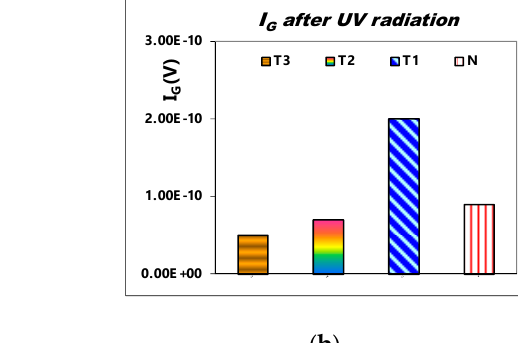
Figure 8. ( a ) The gate-current comparison at V G 30V for various SAHAOS with different PMA temperatures before the UV irradiation condition; ( b ) The gate-current at V G 30V for various SAHAOS with different PMA temperatures after the U100G30 irradiation condition.